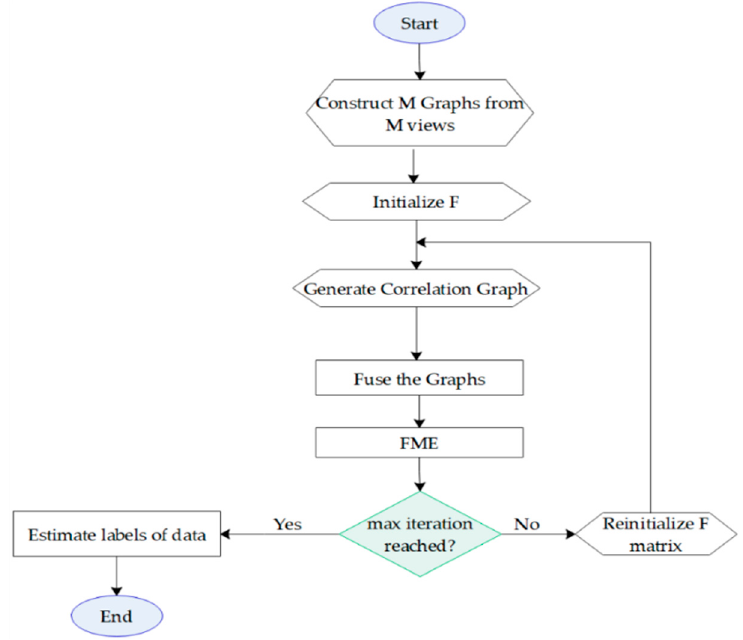
Figure 2. The flowchart of the proposed method.